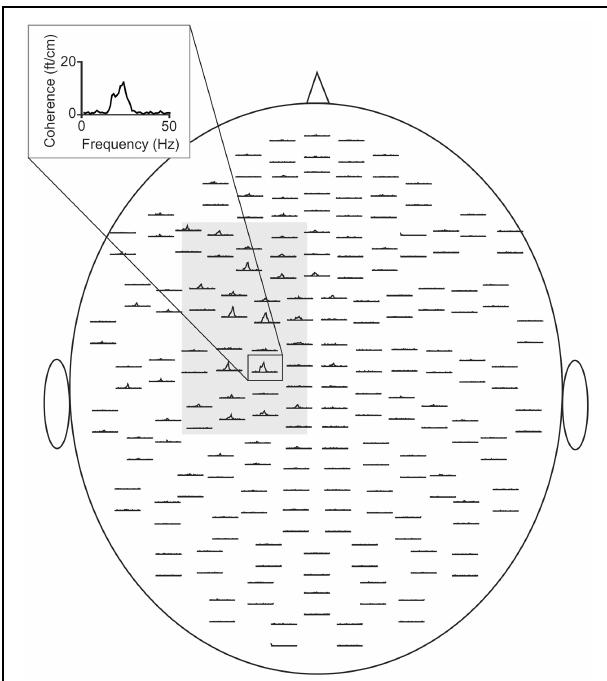
FIGURE 1 | CMC sensor-plot averaged across all subjects prior to tACS. The insert indicates the sensor with the largest amplitude. The gray shaded area represents the sensors selected for the analysis. Data were averaged across this